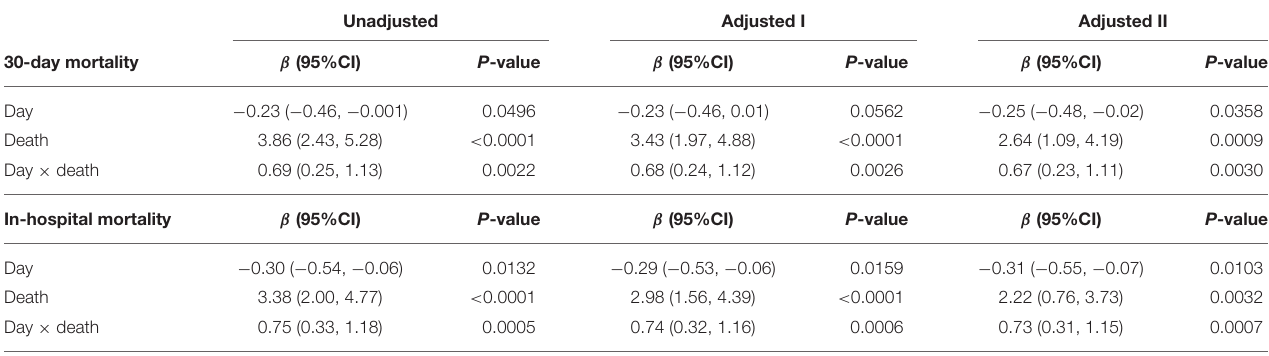
TABLE 5 | Relationship between changes (0–7 days) NLR and short-term mortality in patients with ARDS derived from a generalized additive mixed model (GAMM). Unadjusted Adjusted I Adjusted